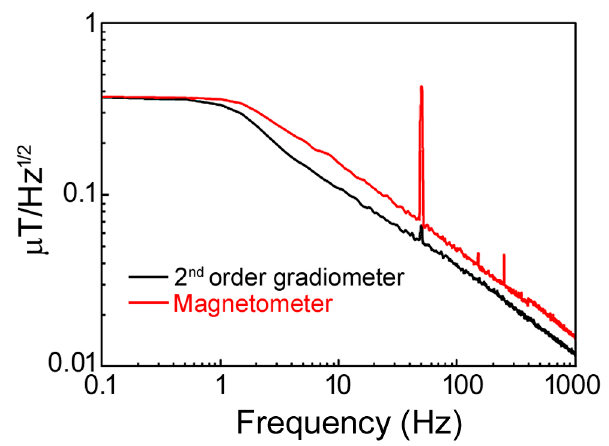
Figure 6. Comparison between the 2nd order GMR gradiometer (black line) and GMR magnetometer spectral noise in a harsh environment.